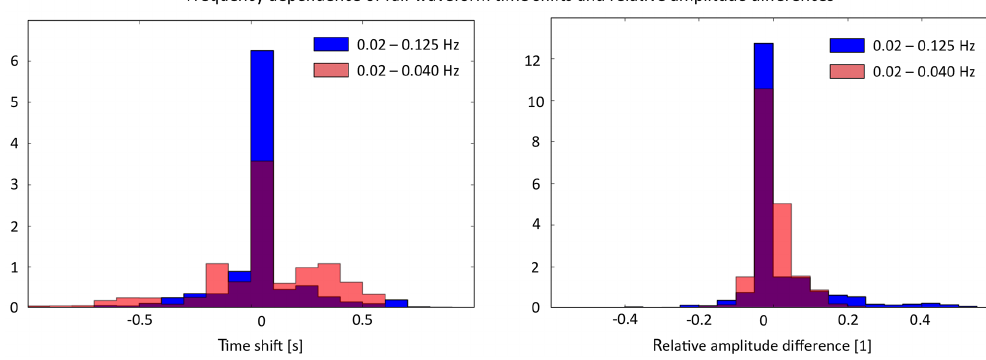
Figure 6. Normalised histograms of time shifts (left) and relative amplitude differences (right) averaged over five random media realisations with 200km lateral and 20km vertical correlation length. The lower frequency band from 0 . 02 to 0 . 04Hz is shown in magenta, and the higher frequency and from 0 . 02 to 0 . 125Hz in blue. Relative amplitude differences at higher frequencies (blue) have a visibly larger spread than at lower frequencies (magenta). The spreads of the time shift histograms are, however, comparable for both frequency bands. A summary of standard deviations in the histograms is provided in Table